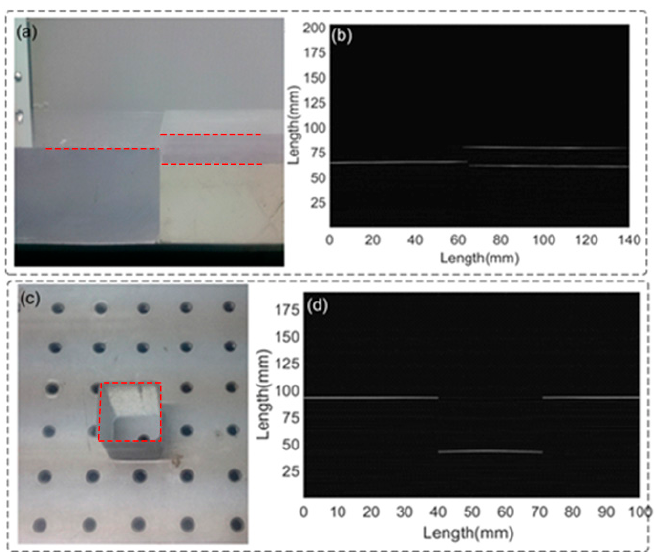
Figure 17. ( a ) Photograph of the step-type Plexiglas model; ( b ) UW image of the physical model; ( c ) Photograph of the sunken plexiglas model; ( d ) UW image of the physical model.